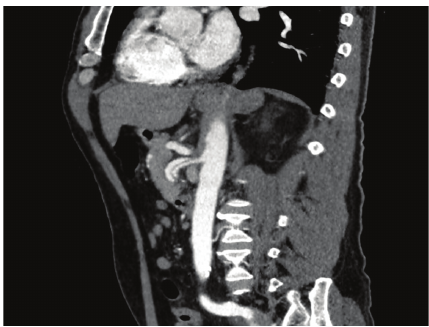
Figure 1: Computed tomography angiogram (sagittal view) depict- ing the dissection of the superior mesenteric artery extending from the orifice without involving any branch vessel.